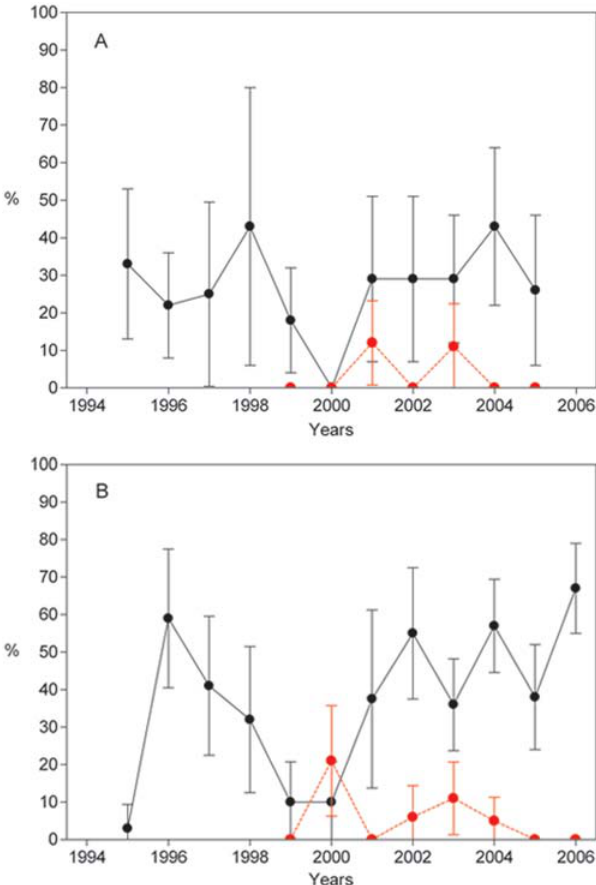
Figure 1. Temporal Variation of the Percentage of Sera and Blood Clot Positives in Bat colonies. Percentage of seropositive (black symbols) and blood clot positive (red symbols) bats observed in M. myotis colonies 1 (A) and 2 (B) (95% confidence interval shown).